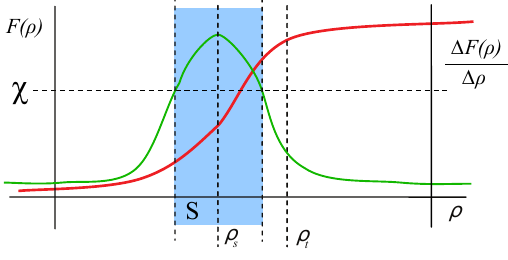
Figure 1. Calibration curve ( red ) and sensitivity ( green ) for the visual acquisition system ( VAS ) including tuning ρ s and working point ρ t